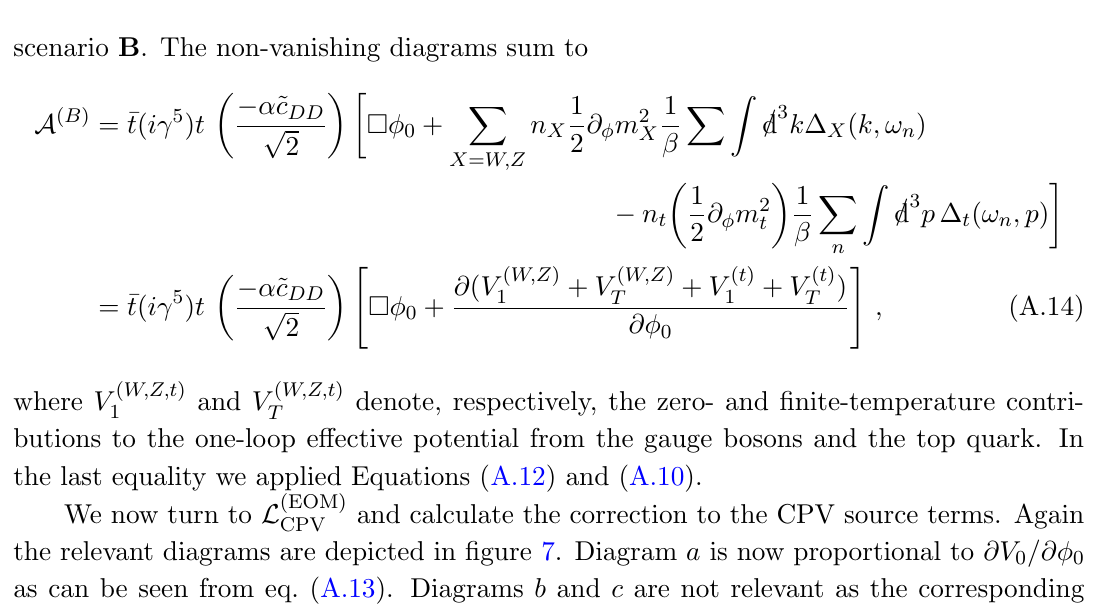
Figure 7 . Tree- and one-loop diagrams contribution to the CP-violating source term in the three scenarios under investigation. Squares denote interactions from eq. (A.13). For the other notation, see (cid:12)gure 6. Only one topology for each diagram is